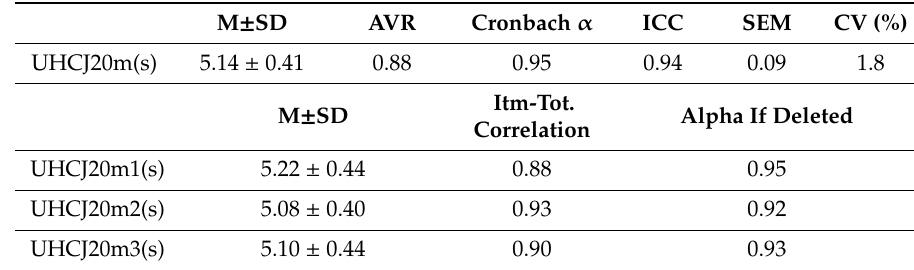
Table 4. Reliability coe ffi cients of the composite measuring instrument 20 m unilateral horizontal cyclic jumps. M ± SD